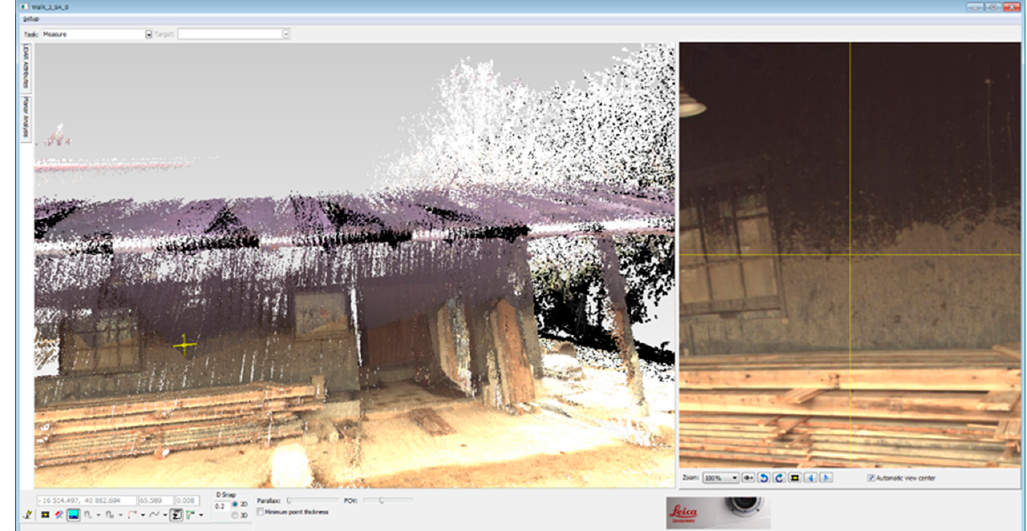
Figure 9. Results of superimposing ( left ) the color of the image captured by the camera ( right ) on the laser point cloud.